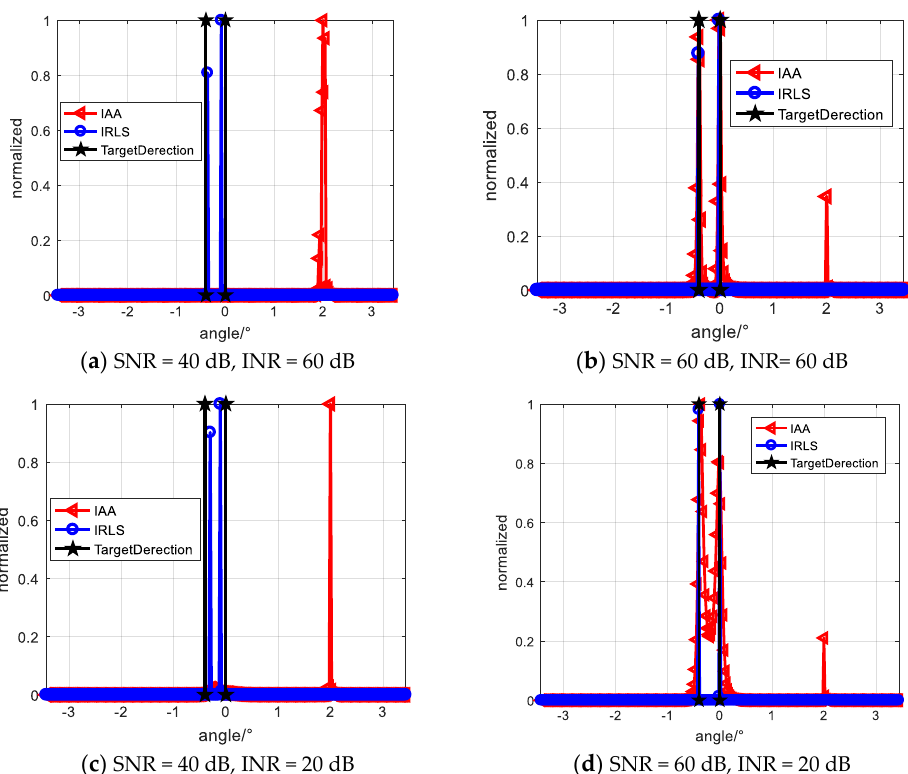
Figure 8. Super-resolution comparison with near main-lobe interference, direction of 2°.